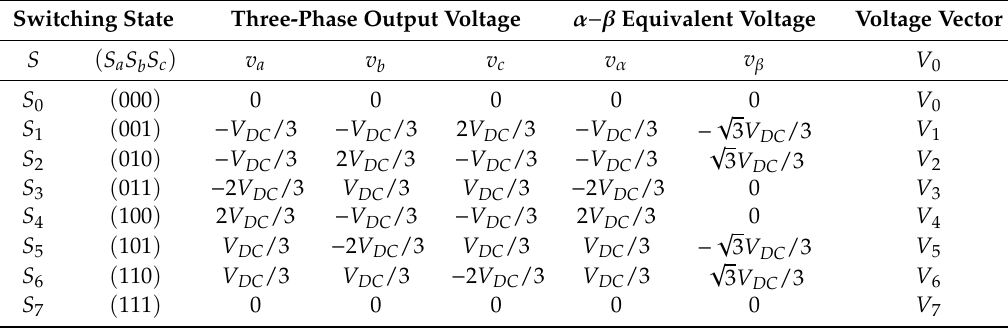
Figure 2. A diagram of voltage vectors. Table 1. Three-phase six-switch VSI switching state table.